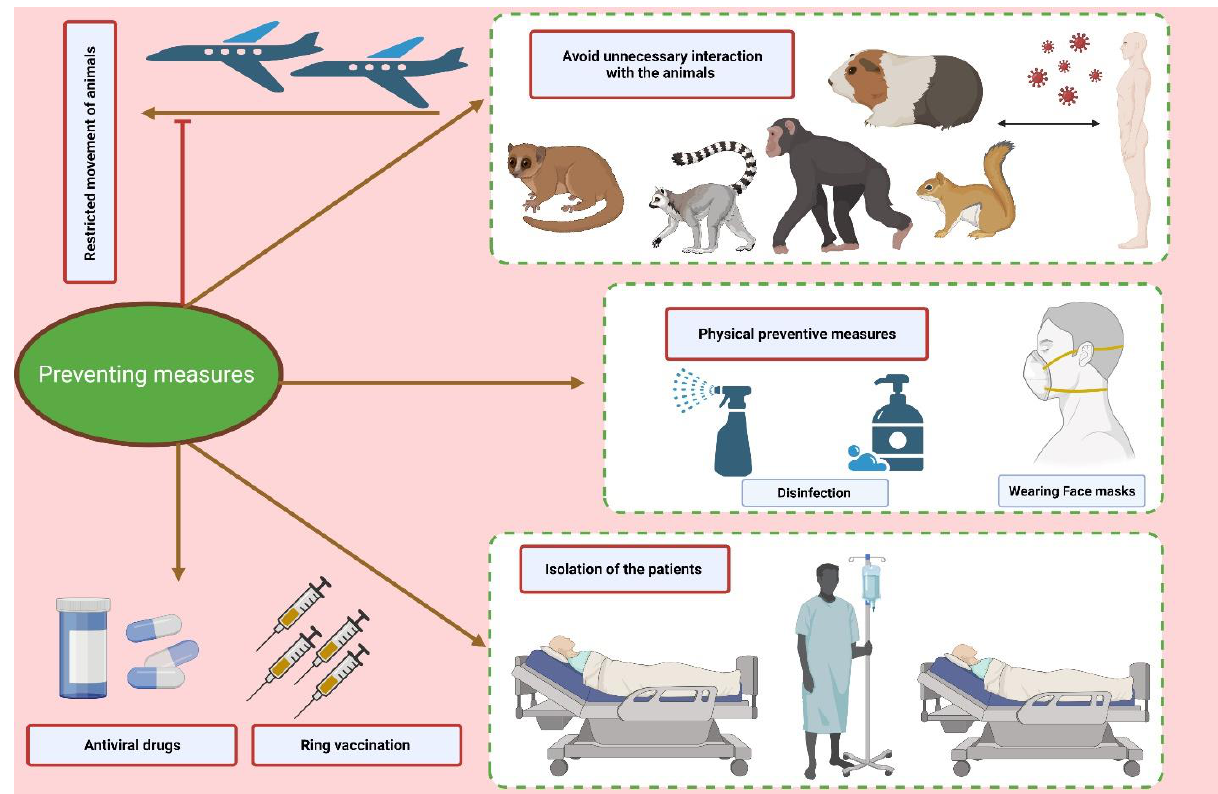
Figure 4. The figure represents the various preventive measures to contain the deleterious conse- quences of the monkeypox